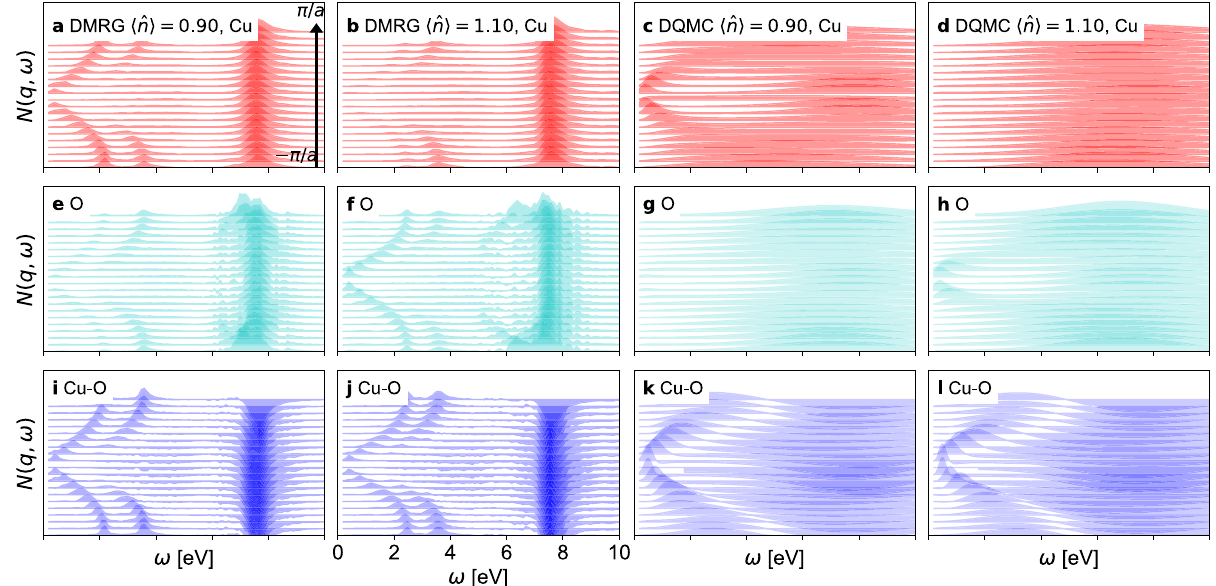
Fig. 10 The orbital-resolved dynamical charge structure factor N ( q , ω ) of the Cu − O pd -model. Results were computed using the density matrix renormalization group (DMRG) and determinant quantum Monte Carlo (DQMC) methods. Panels a − l show results as a function of energy ω for fi lling values of h ^ n i ¼ 0 : 9 and 1.1 holes/Cu. Red, cyan, and blue colors represent Cu d x 2 (cid:1) y 2 , O 2 p , and Cu − O components, respectively. From bottom to top, the momentum q increases from − π / a to π / a in each panel. The parameters for the pd -model, which includes the full Cu and O basis, in both cases, are identical to those used in Figs. 4 and